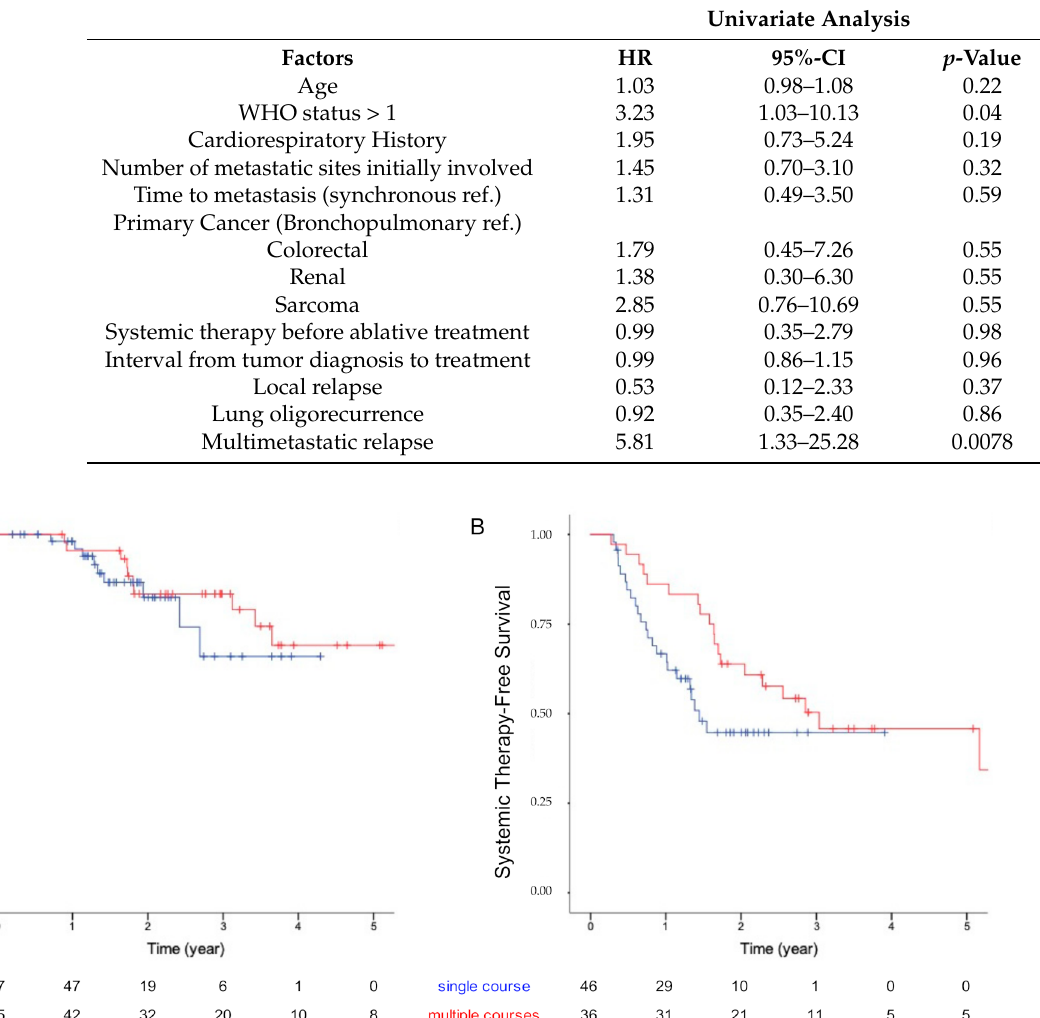
Table 3. Univariate analysis for OS for whole cohort.